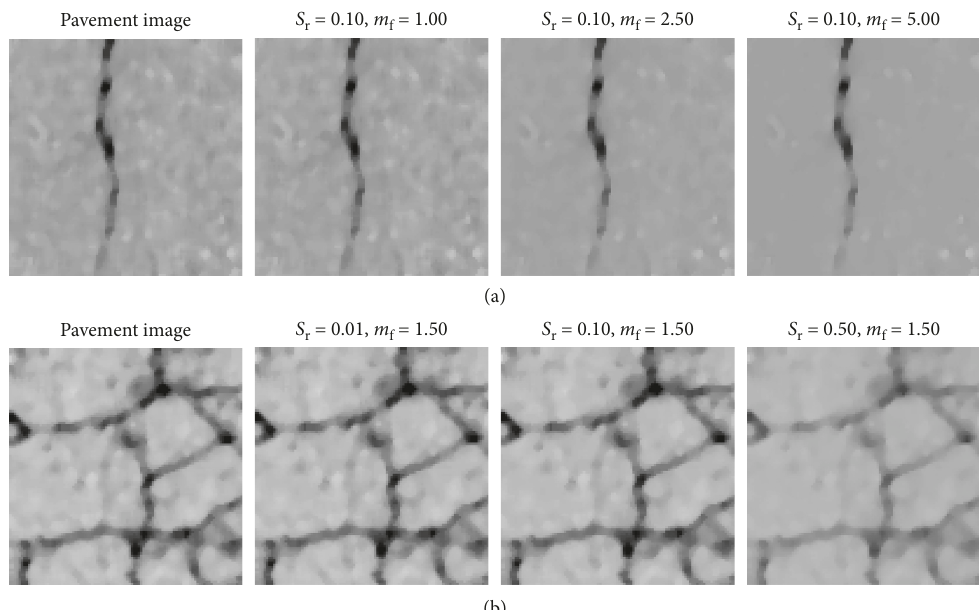
Figure 1: Image processed by FLLF with different values of